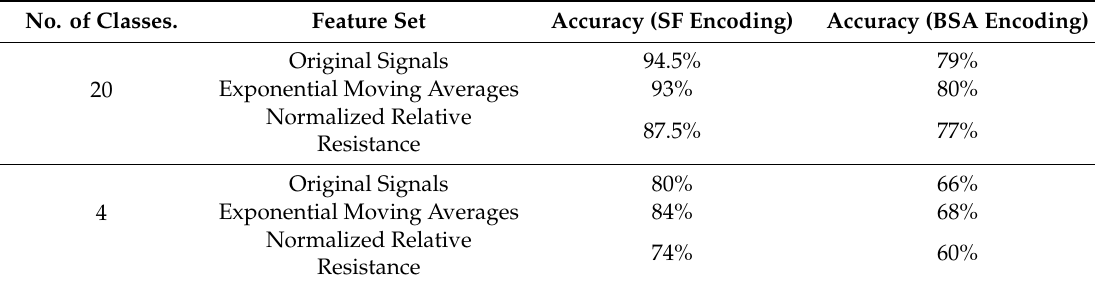
Table 4. Classification performance of the 3D SNN